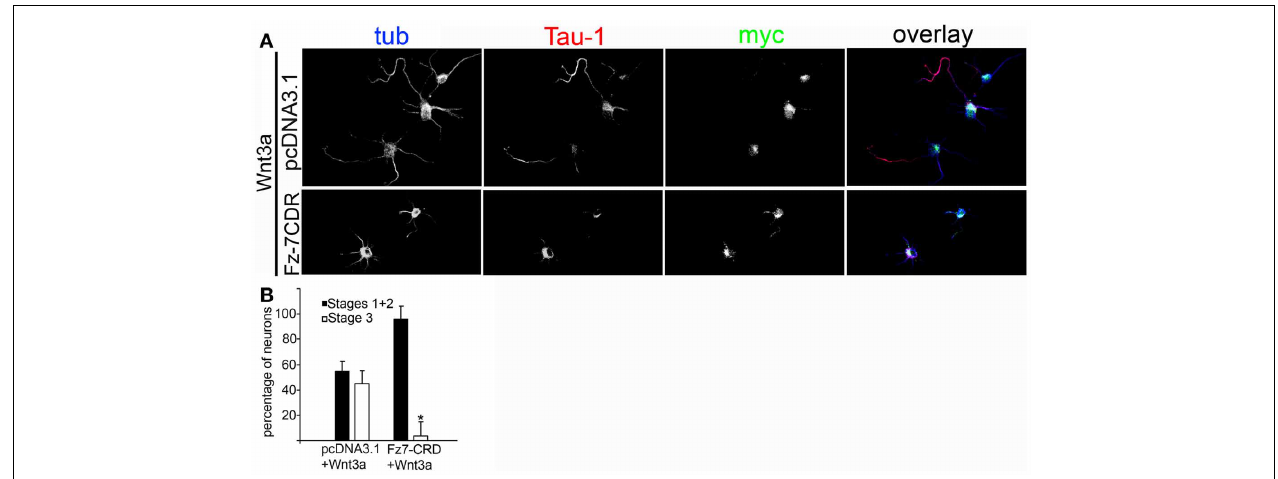
FIGURE 8 | (A) Wnt3a polarizing effect depends on the activation of Fz7. Double immunofluorescence micrographs of hippocampal neurons incubated for 24h in the presence of 1.35nM Wnt3a showing the distribution of the axonal marker Tau-1 and the neuronal marker β -III-tubulin. myc is a marker of transfection with the negative dominant form of Fz7-CRD. Scale bar: 20mm.